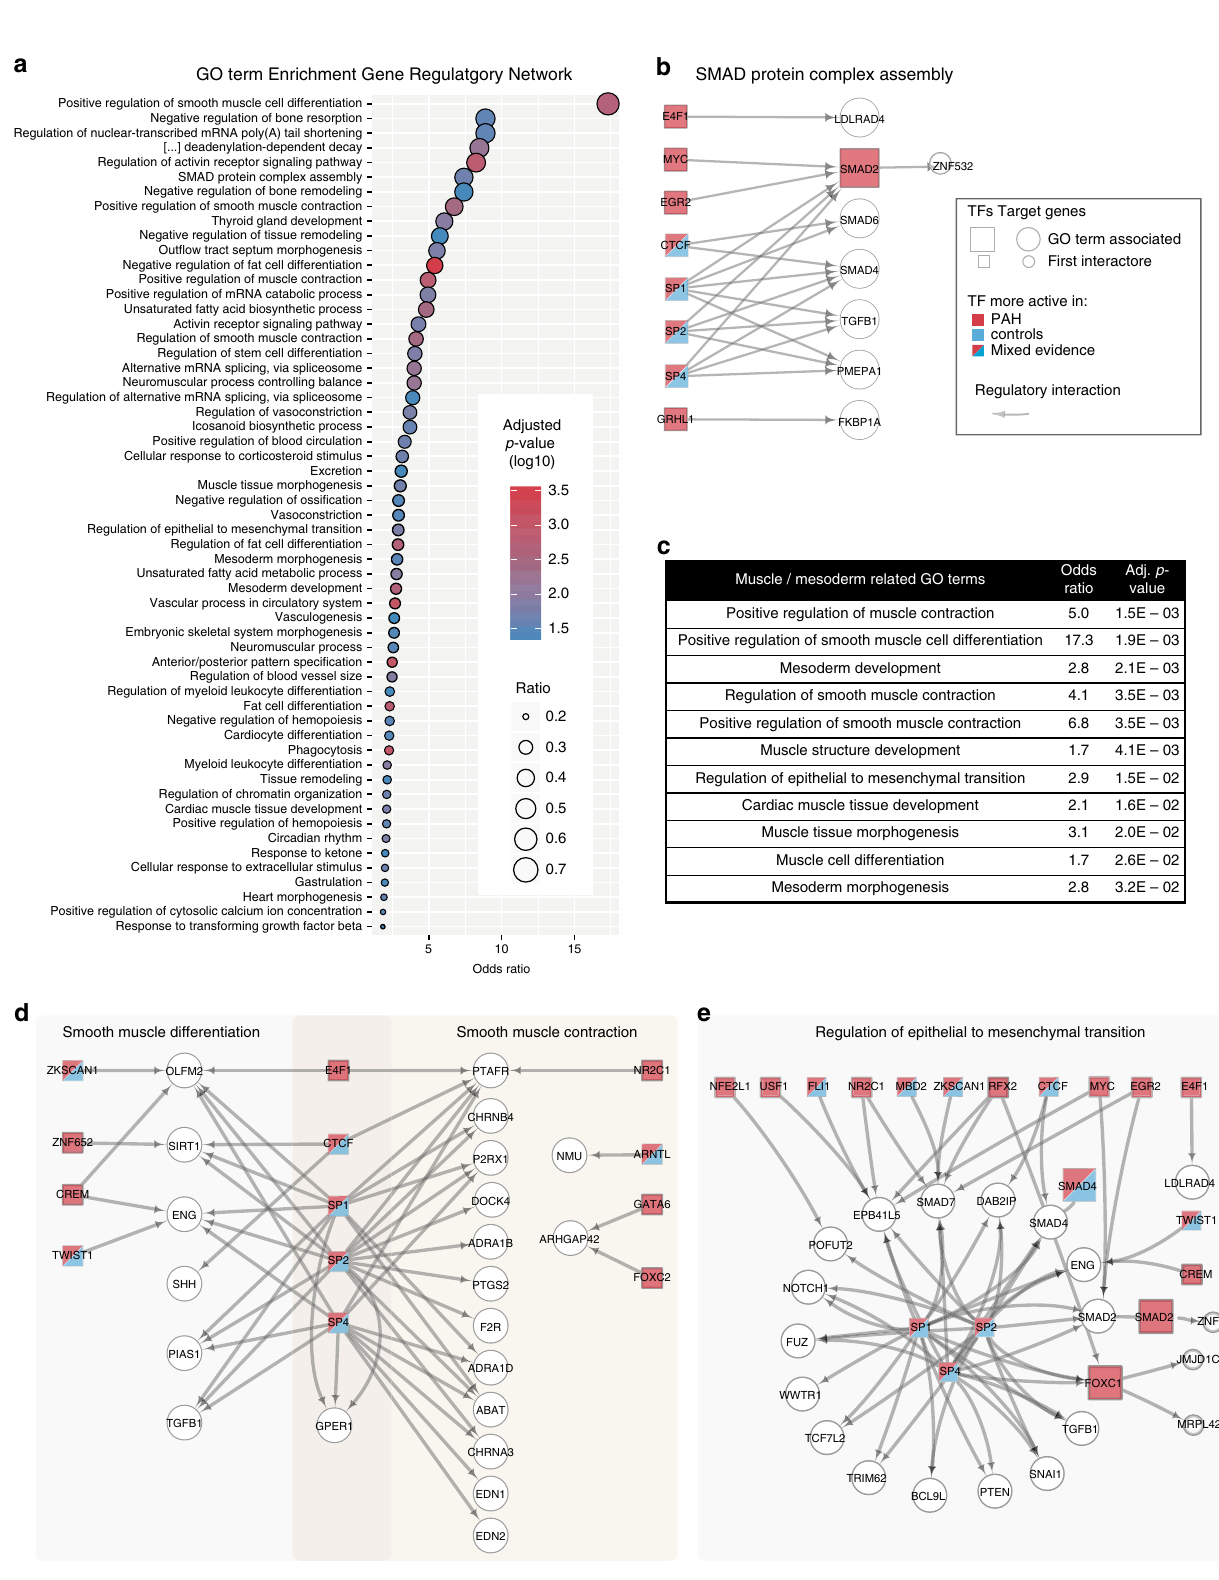
Fig. 5 Functional analysis of genes targeted by differential PAH-TFs. a Enrichment of gene ontology (GO) annotations for target genes in PAH-speci fi c GRN (adj. p -val < 0.05). Only GO terms that have between 3 and 80 genes are shown and some highly redundant terms were removed (full list in Supplementary Data 6). All expressed genes were used as background. b Network of target genes associated with the GO term “ SMAD complex assembly ” (large nodes) and their fi rst interactors (small nodes). c GO terms related to “ muscle ” and “ mesenchyme ” that were enriched among the target genes of the PAH-speci fi c GRN. d Network of target genes associated with the GO terms “ Smooth muscle differentiation ” and/or “ Smooth muscle contraction ” (large nodes) and their fi rst interactors (small nodes). Color code as in b . e Network of target genes associated with the GO terms “ Regulation of epithelial to mesenchymal transition ” (large nodes) and their fi rst interactors (small nodes). Color code of the nodes as in b